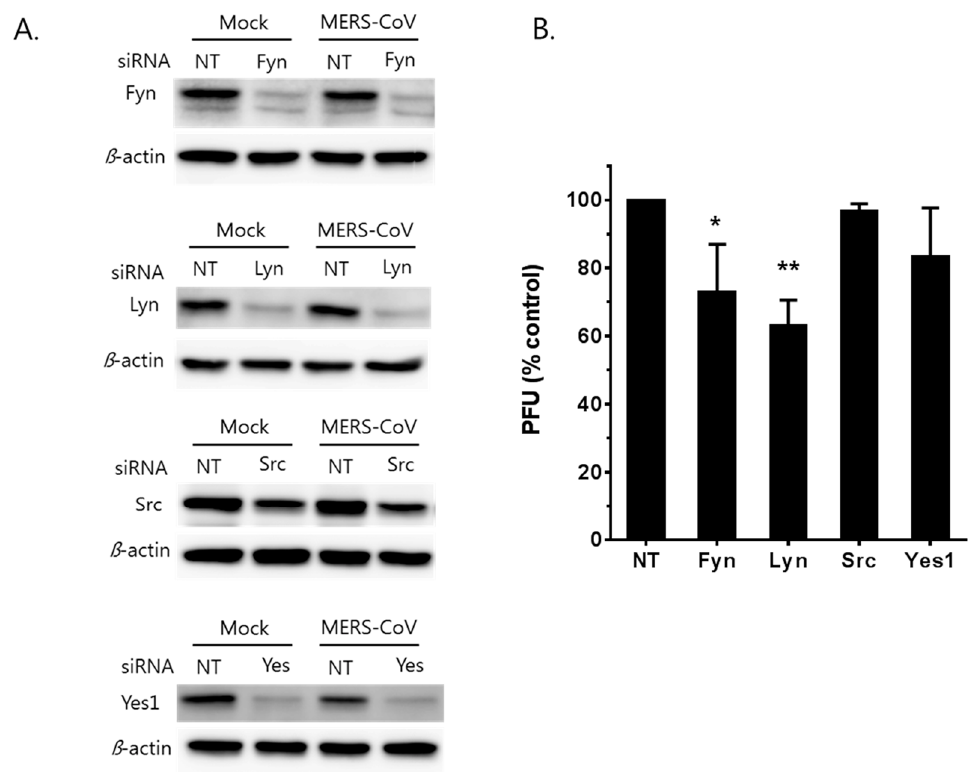
Figure 4. MERS-CoV is sensitive to RNA-mediated depletion of Fyn and Lyn kinases. ( A ) Specific knockdown of Fyn, Lyn, Src, and Yes kinases. Huh-7 cells were transfected with 100 nM nontargeting (NT) siRNA or siRNAs targeting Fyn, Lyn, Src, and Yes mRNA. At 48 h post-transfection, the cells were infected with MERS-CoV at an MOI of 0.02. After 12 h of infection, lysates of infected cells were collected and subjected to Western blot analyses. The β -actin was used as the loading control. The result of a representative experiment out of two repeats is shown. ( B ) Specific knockdowns of Fyn and Lyn interfere with the production of infectious MERS-CoV from siRNA transfected cells. Data presented is from means ± SD of 3 independent experiments. Significant differences are indicated by * p < 0.05, ** p < 0.01.